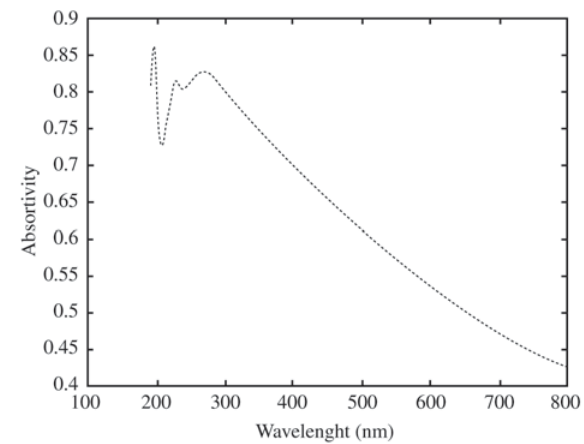
Figure 6 . Results of the Analyses Spectrophotometric of the used pigment.